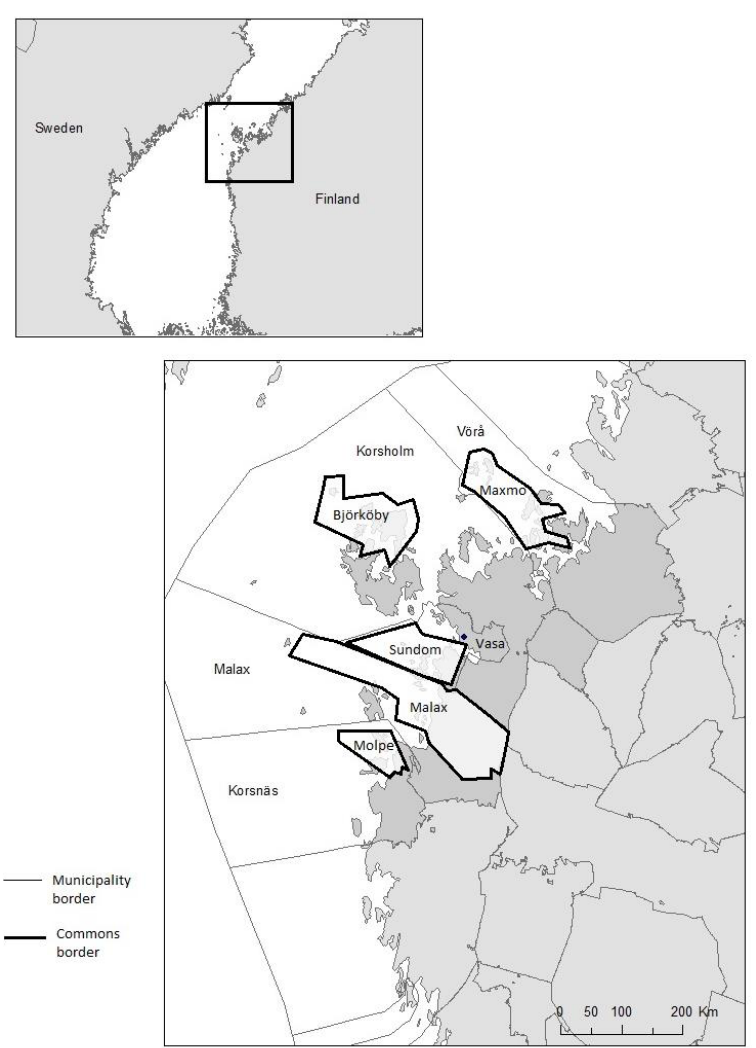
Figure 1 . The World Heritage municipalities and the studied commons (Svels & Åkerlund Figure 1. The World Heritage municipalities and the studied commons (Svels & Åkerlund, 2018)